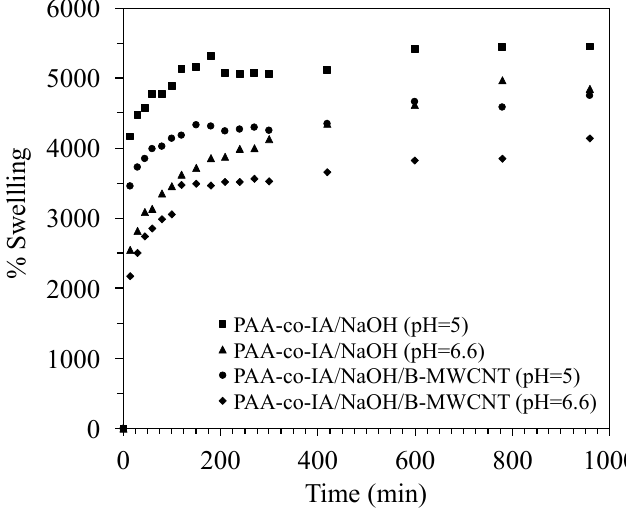
Figure 4. Swelling kinetics of pure (PAA-co-IA) and modified (PAA-co-IA/B-MWCNT) hydrogels in aqueous buffered solutions (pH = 5 and pH = 6.6) at room temperature.